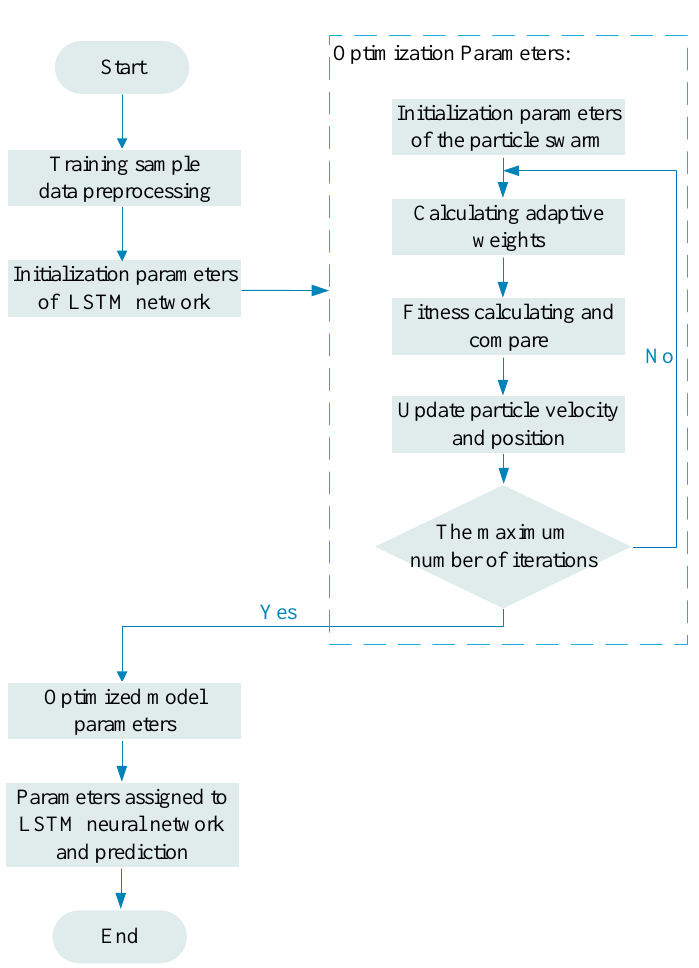
Figure 3. The flowchart of adaptive PSO–LSTM prediction